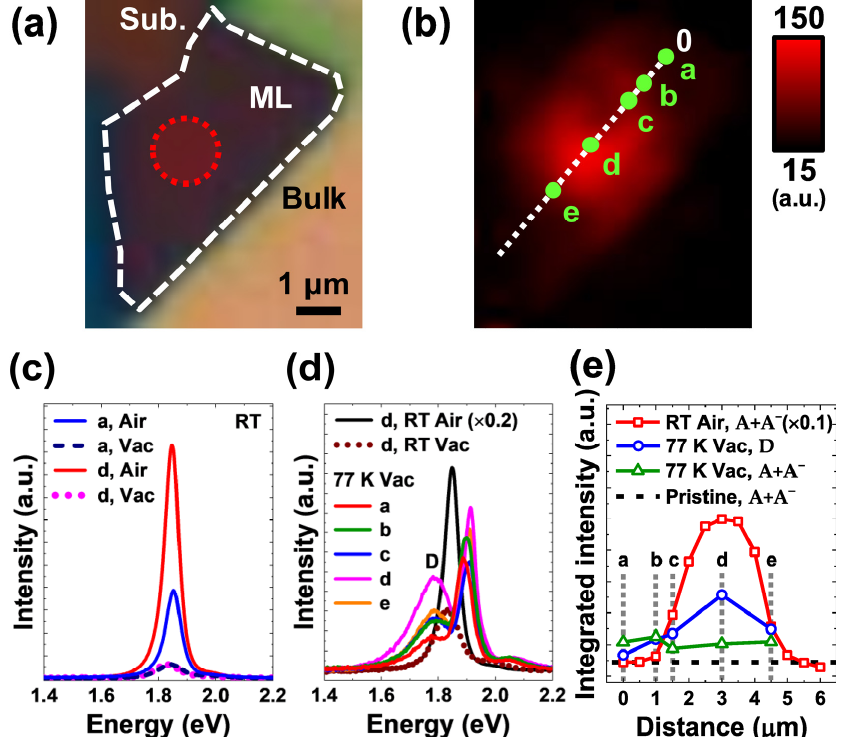
Figure 5. Low-temperature micro-PL characterization of the area-selectively irradiated ML-MoS 2 : ( a ) An OM image of the ML-MoS 2 flake, including the red dashed circle, which indicates the spot for the selective FLI process on the ML region. ( b ) The map of I Total acquired after the FLI process. ( c ) Two pairs of PL spectra measured in the positions of a ( d = 0) and d ( d = 3 µ m) at room temperature (RT) in air and vacuum (Vac). ( d ) A series of PL spectra measured at 77 K in vacuum in the five different positions a–e along the white dashed line in ( b ) across the irradiated region. The positions b, c, and e are located at d = 1, 1.5, and 4.5 µ m, respectively. For comparison, the PL spectra measured in position d at RT in ( c ) are also drawn together. ( e ) The variations in I at RT in air and at 77 K A + A − in vacuum and the integrated intensity of defect-activated peak (D), I D , with d . For a comparison, ( e ) includes the ambient I measured from the pristine ML-MoS 2 before the FLI process at RT. A + A − Note that in ( d ), the peak height of the PL spectrum of the position d measured at RT in air is divided by 5, and in ( e ), I at RT in air is divided by 10. Only the series of I measurements at RT in A + A − A + A − air in ( e ) was carried out in the ambient, while all the other PL experiments were conducted on the sample in the